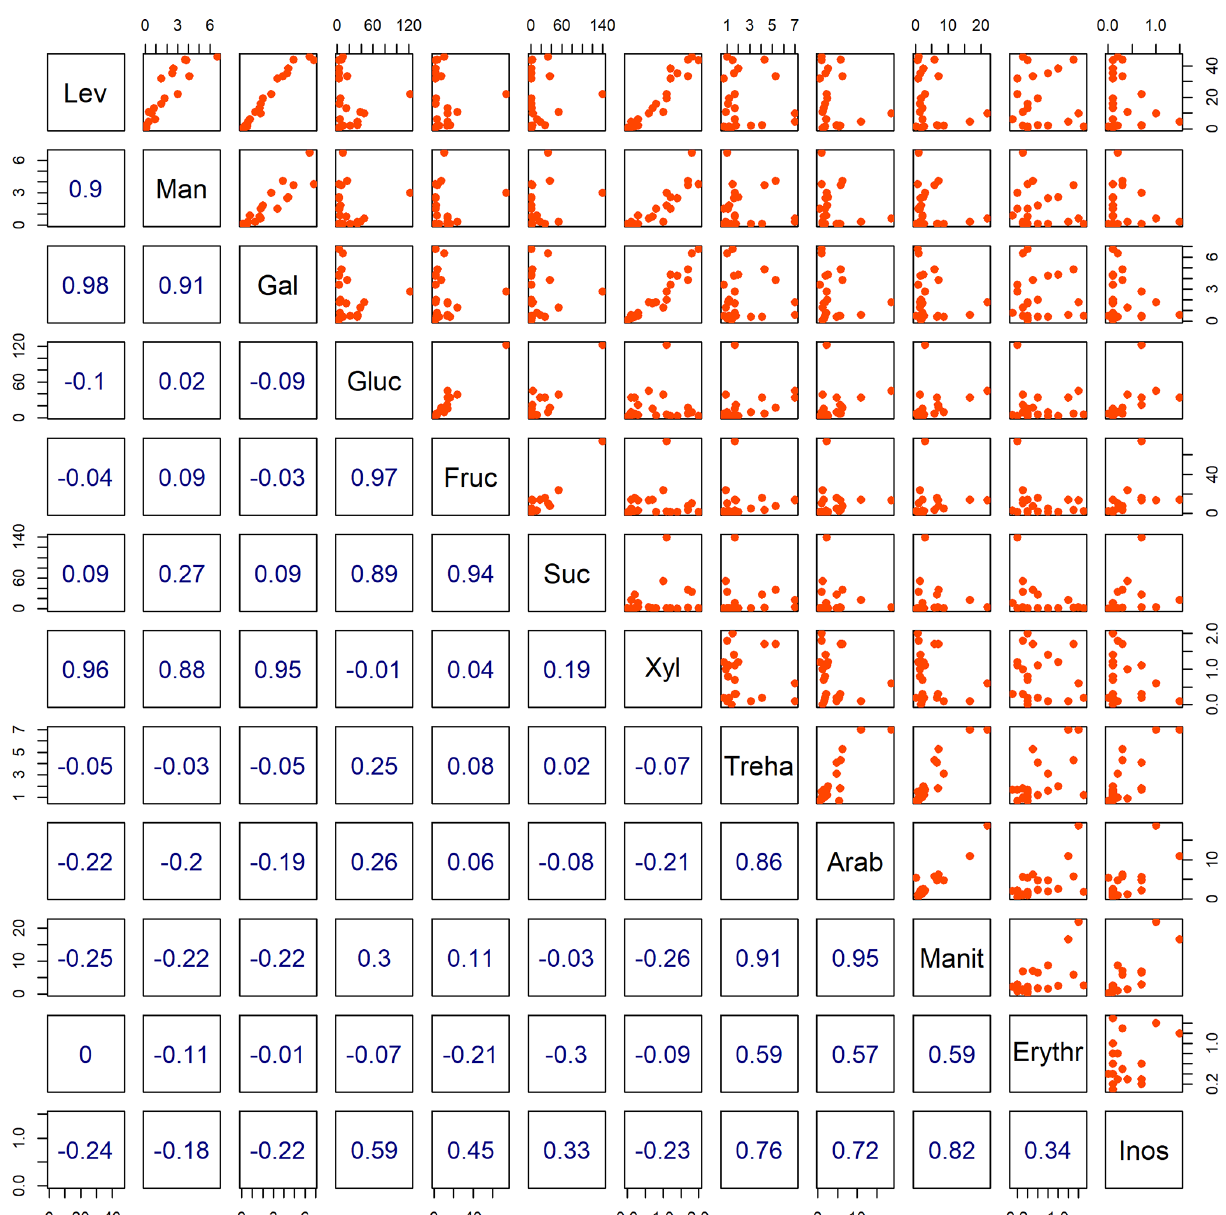
Figure 4. Multiple linear regression (MLR) analysis of airborne sugar compounds in TSP collected over